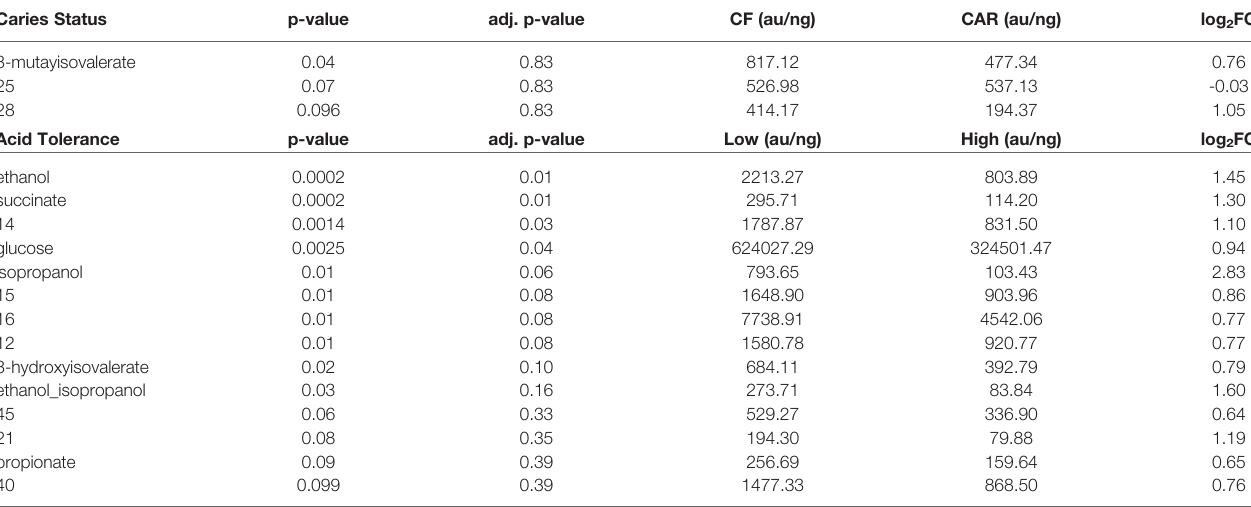
TABLE 1 | Metabolites signi fi cantly associated with caries status or with the acidogenicity of plaque. Caries